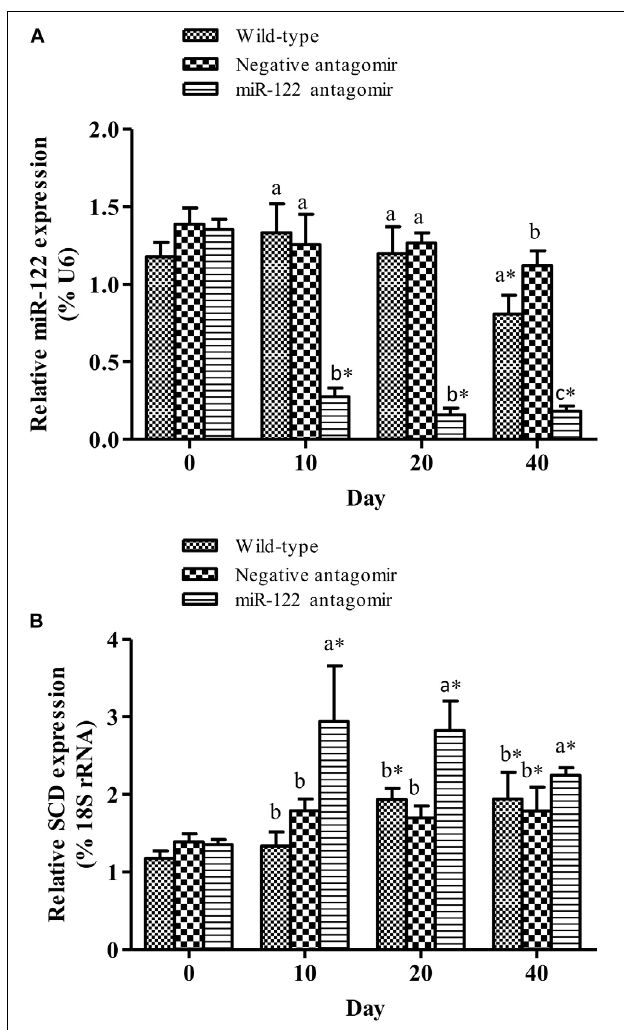
FIGURE 3 | Effect of inhibition of miR-122 on hepatic SCD expression in GIFT. Juvenile GIFT weighing about 3.8 g were injected in tail vein with PBS, miR-122 negative control, or miR-122 antagomir (dose, 50 mg kg - 1 body weight) every 6 days for 40 days. GIFT injected with PBS served as control. (A) The expression of miR-122 in liver was detected on days 0, 10, 20, and 40 using qRT-PCR, with U6 as the reference gene. (B) The expression of SCD in liver was detected on days 0, 10, 20, and 40 using qRT-PCR, with 18S rRNA as the reference gene. ∗ P < 0.05 indicates significant differences in each group among sampling points (paired-samples t test). The data were expressed as the relative change compared with the control group on day 0. Different lowercase letters show significant differences among treatments at each sampling point ( P < 0.05, Duncan’s multiple range test).